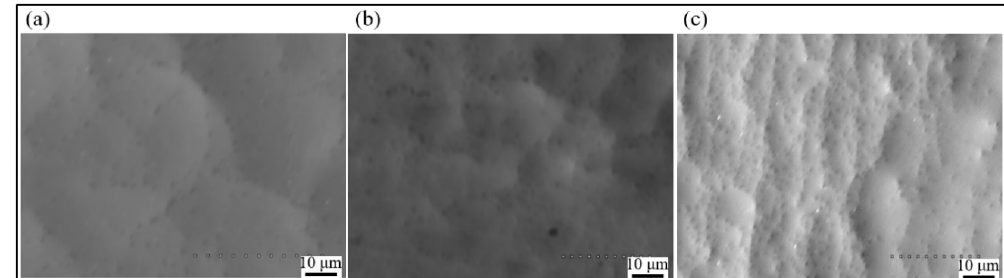
Figure 4. XRD diffraction patterns of Ni-11P plated layer. Figure 5. SEM micrographs of surface morphology of plated layers. The plated layers were obtained in the bath containing 0.5 M H 3 PO 3 , with: ( a ) C.D.: 1.0 A/dm 2 , plating time: 180 min and thickness: 18